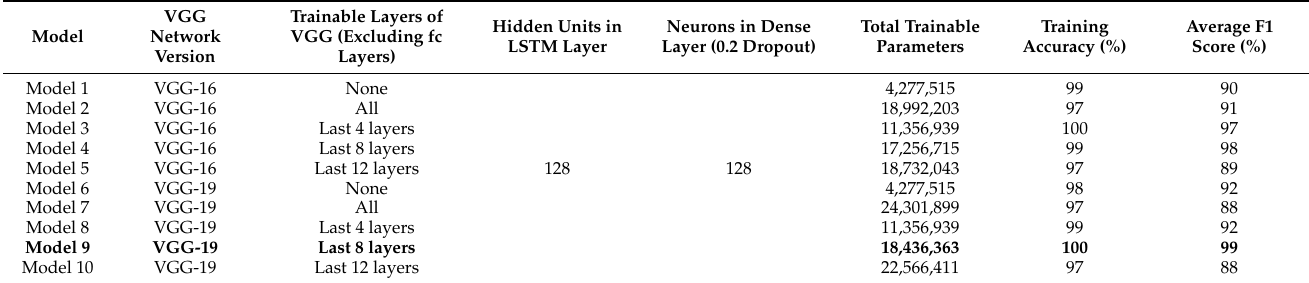
Table 5. Network configuration and f1 score of fine-tuned VGG models.